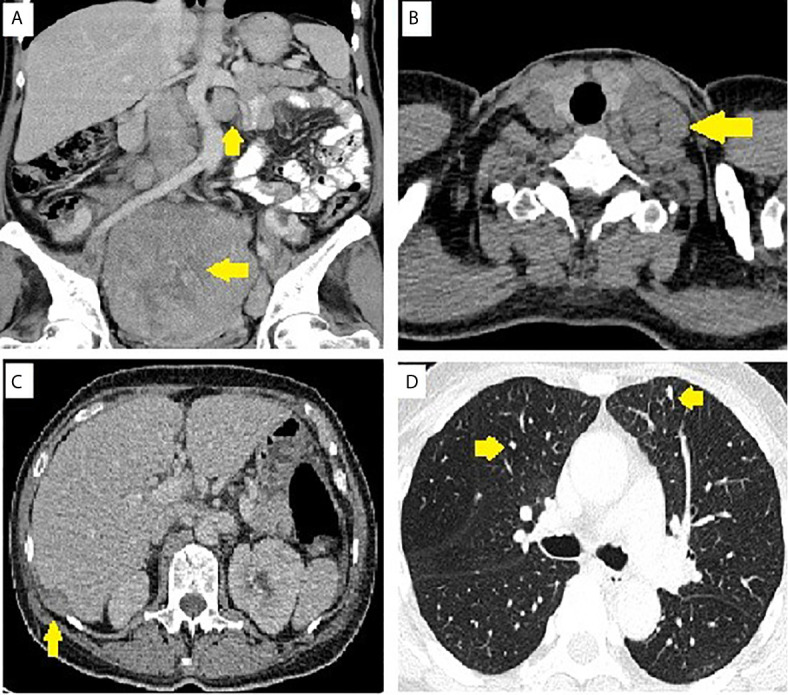
Image of pelvic tumor and metastasis. (A) Para-aortic lymph nodes and pelvic tumor. (B) Supraclavicular lymph nodes. (C) Sub-diaphragmatic seeding. (D) Lung metastasis.